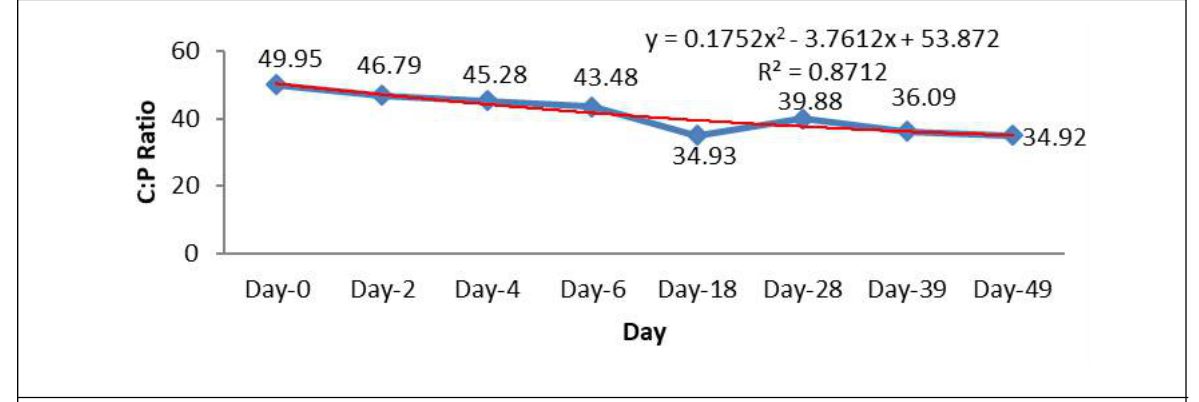
Figure 2: C:P ratio variation during WBM ( A. bisporus ) composting and cultivation